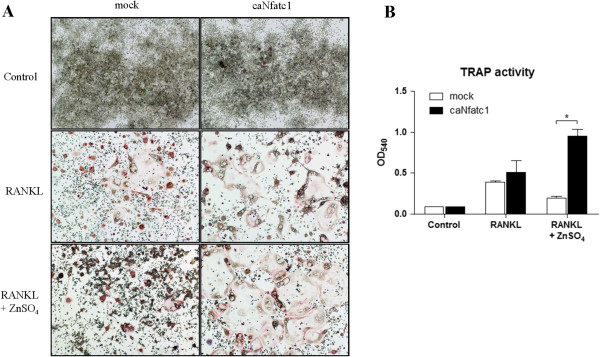
Nfatc1 rescues the inhibitory effects of zinc during osteoclastogenesis in RAW264.7 cells. (A, B) After electroporation with the mock (A, left panel) and constitutively active form of Nfatc1 (B, right panel), RAW264.7 cells were cultured for 4 days with RANKL (35 ng/ml) in the absence or presence of ZnSO4 (100 μM) (n=3). Osteoclast formation was visualized using TRAP staining in panel A. TRAP activity is shown in panel B. Data are presented as the mean ± S.D. of three independent experiments; * p < 0.05 compared to RANKL (R).